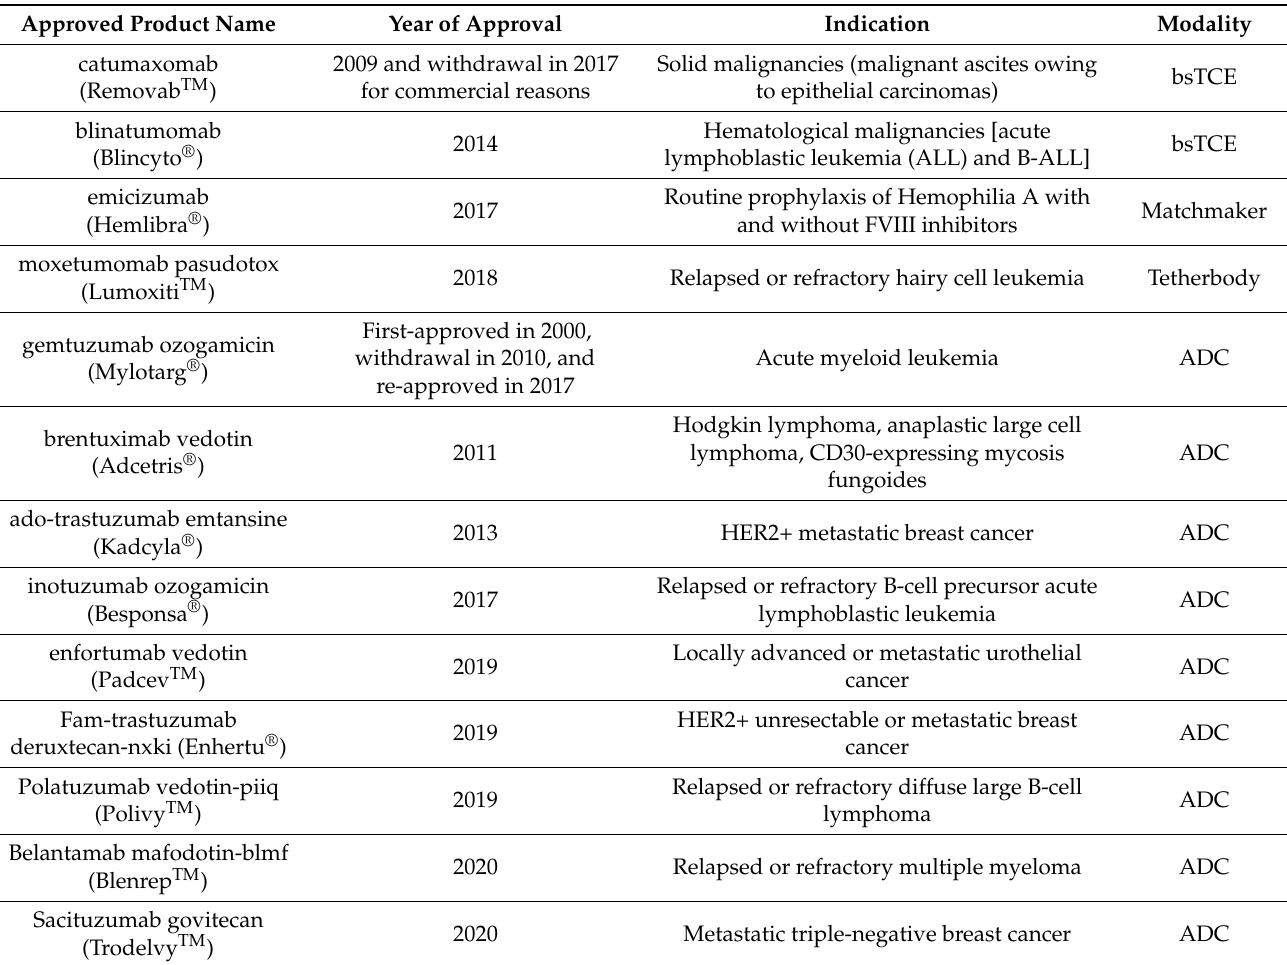
Table 3. Approved products for multispecific